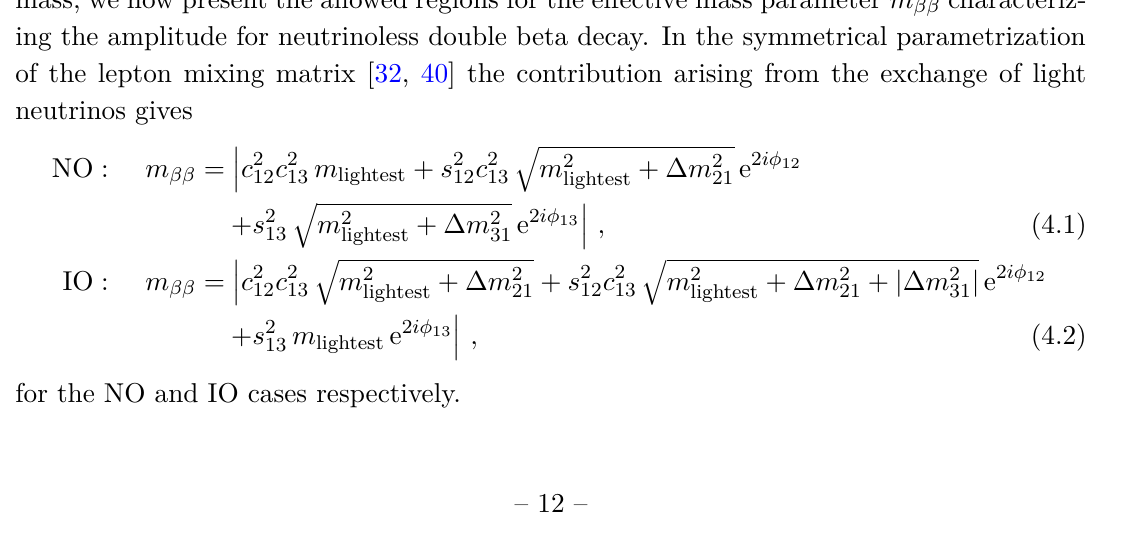
coming from the cosmological bound on lightest